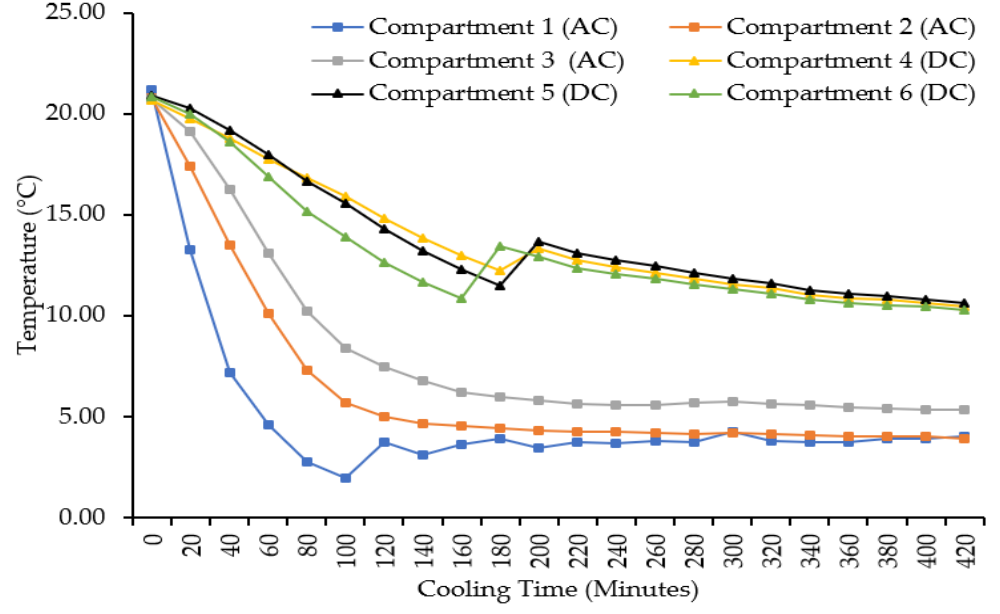
Figure 4. Temperature changes in individual compartments (with natural air circulation).